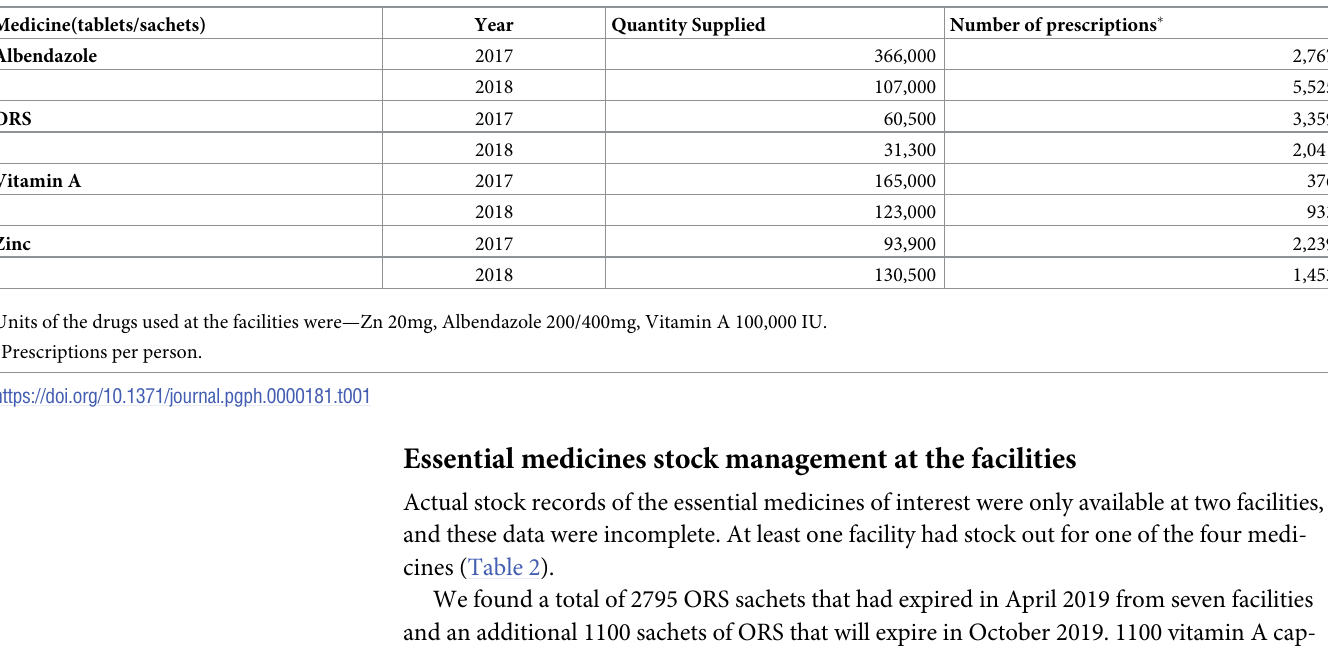
Table 1. Quantity supplied from the National Medical Stores and number of prescriptions at the facilities for the four essential medicines, 2017 and 2018. Medicine(tablets/sachets)